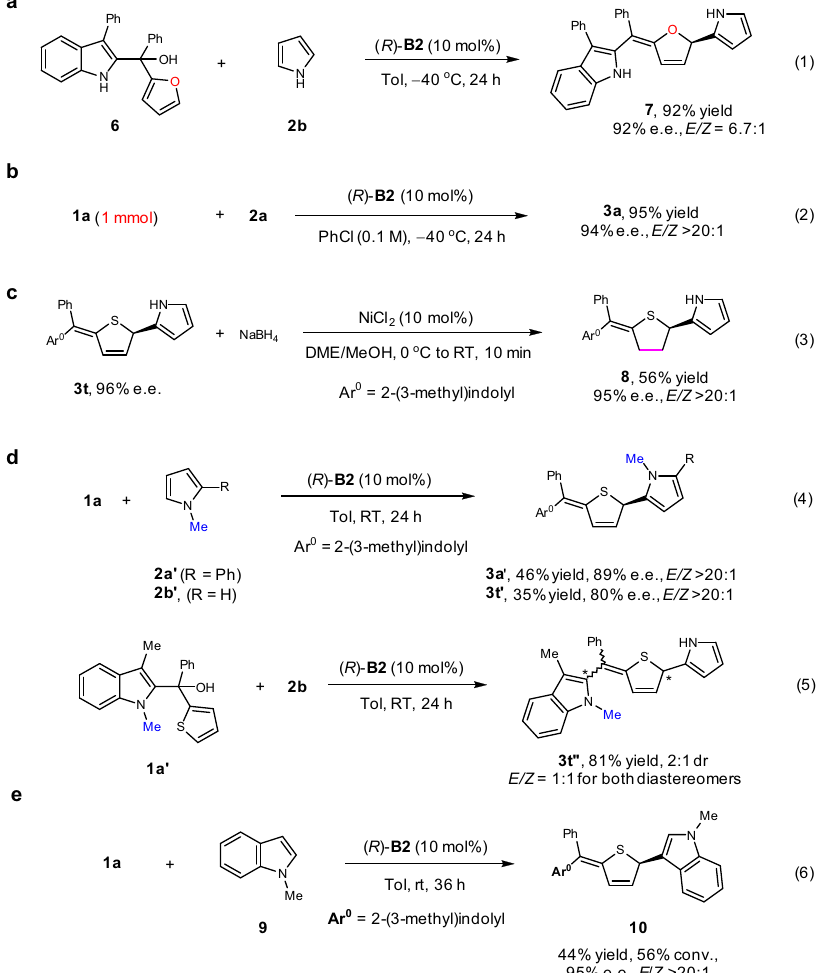
Fig. 2 Scale-up synthesis, synthetic application, and control experiments. a Reaction extension to asymmetric dearomatization of the furan ring. b Mmol- scale synthesis. c Selective reduction of C-C double bond. d Control experiments with N -substituted substrates. e Reaction extension to N -methyl indole as the